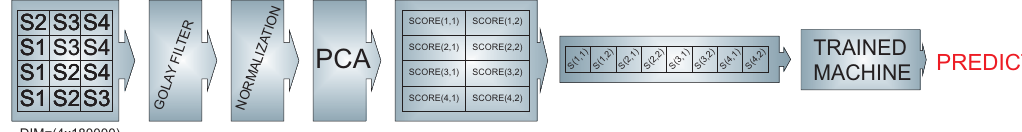
Figure 7. Methodology for prediction.